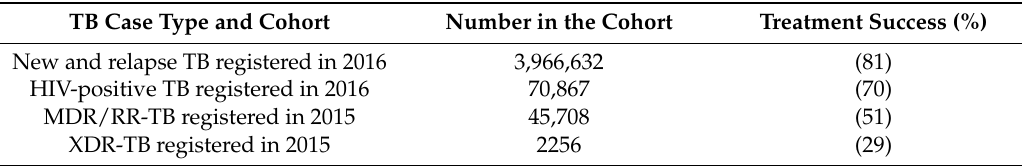
Table 2. Treatment success rates for patients with tuberculosis, including those with HIV-positive and drug-resistant disease, in the Asia-Pacific region. TB Case Type and